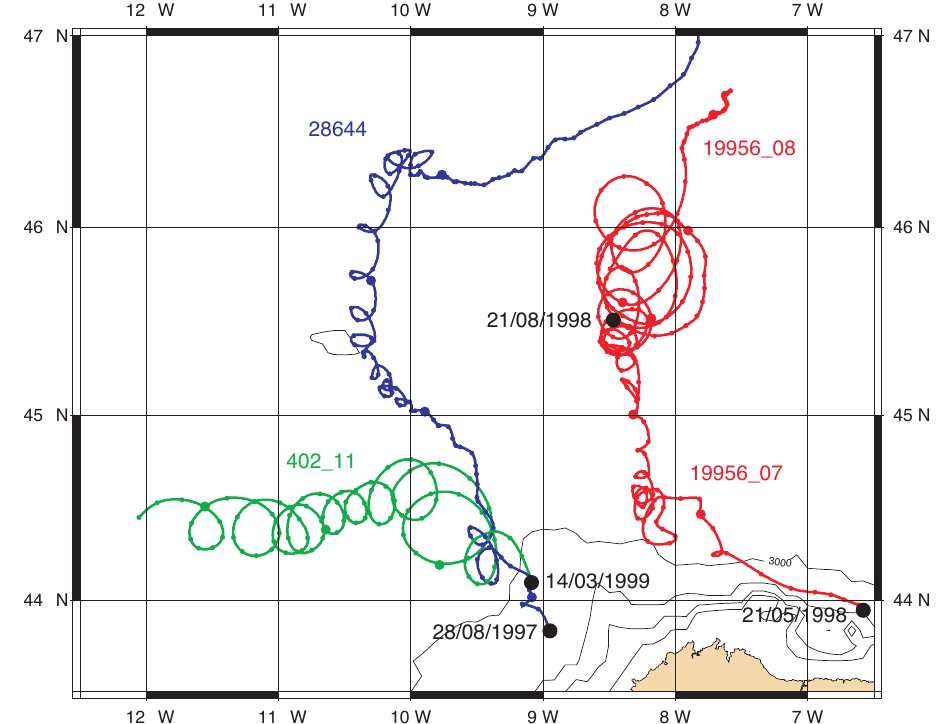
F IG . 8. – Low-pass filtered trajectories of Rafos 28644 (blue) at the 450 m depth level, Marvor 402 (green, cycle 11), and Marvor 19956, cycles 7 and 8 (red) for different years (1997, 1998, 1999). Black dots indicate the beginning of trajectories. Coloured small dots indicate days and coloured bigger dots indicate beginning of